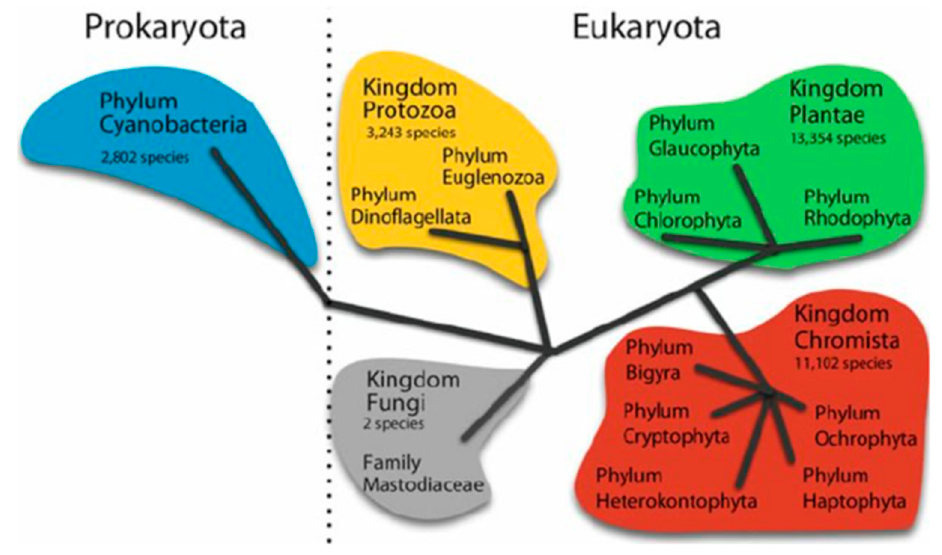
Figure 1. Distribution of algae among groups in the Tree of Life as recognized by the ITIS and Species 2000 (and ife.org) in 2011. The deep classification of algae is the subject of great debate, and even the higher clades have been discussed and revised recently [8–10].